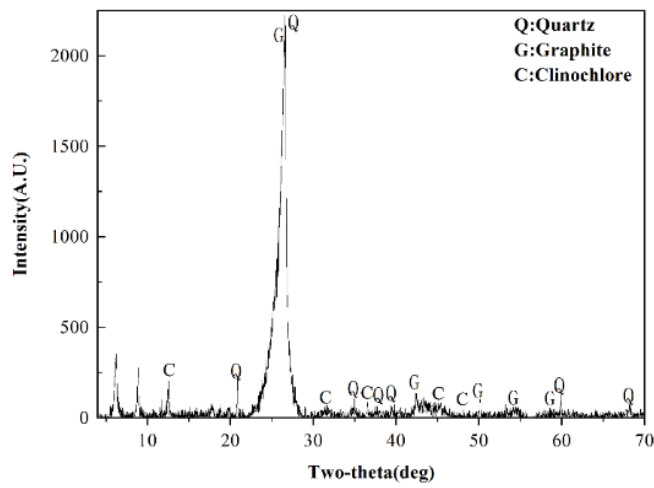
Figure 1. XRD pattern of graphite.